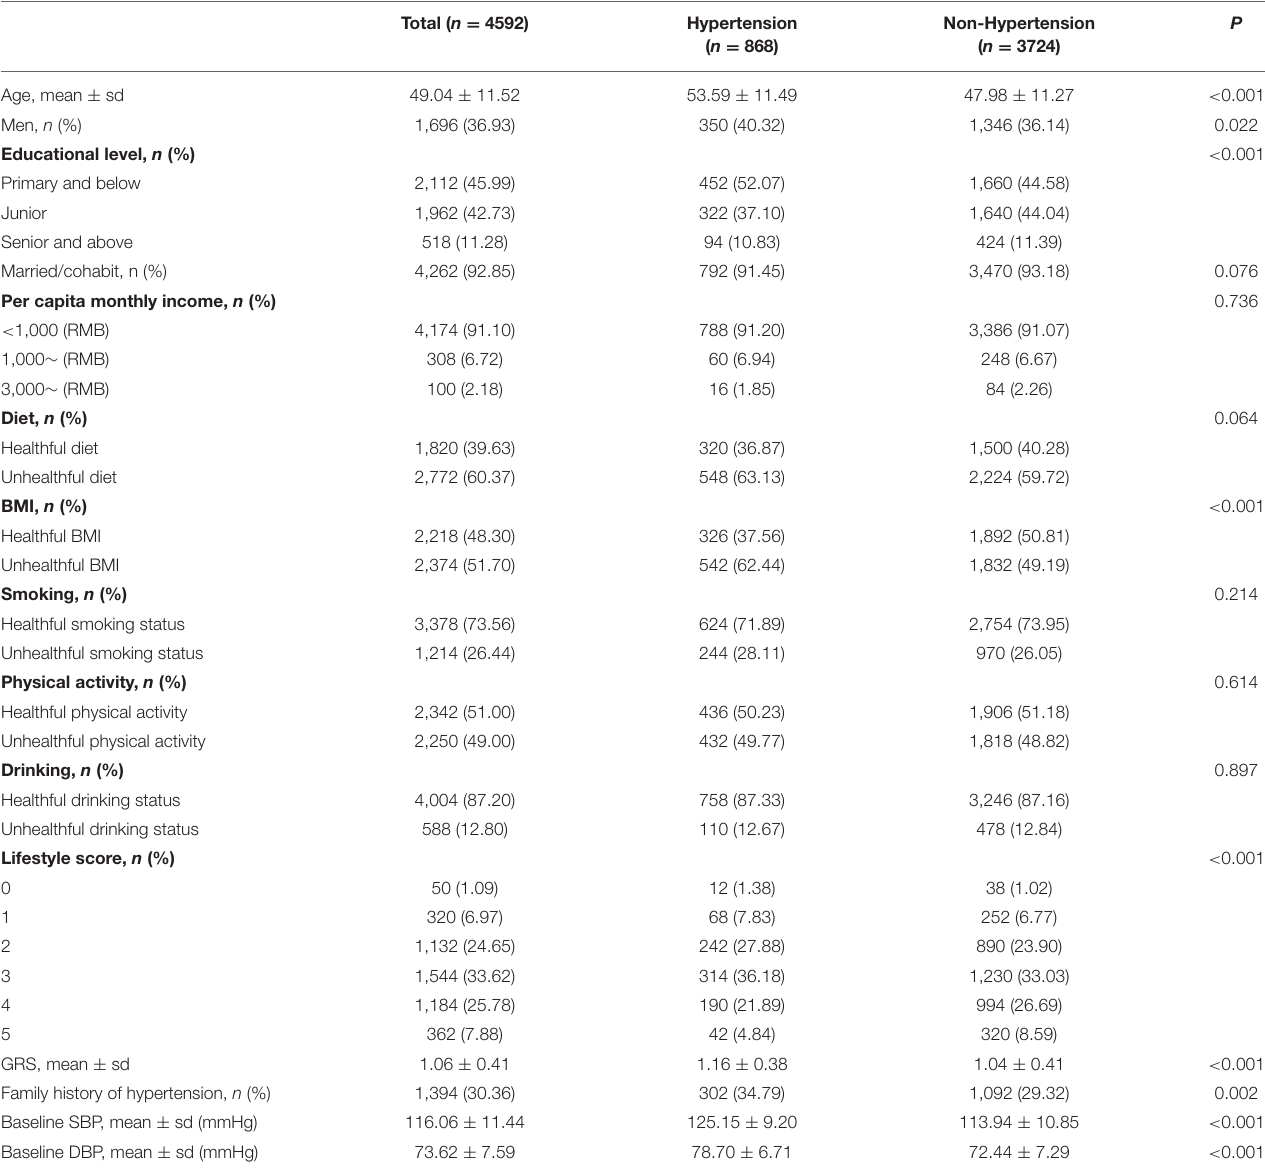
TABLE 1 | Characteristics of hypertensive and non-hypertensive